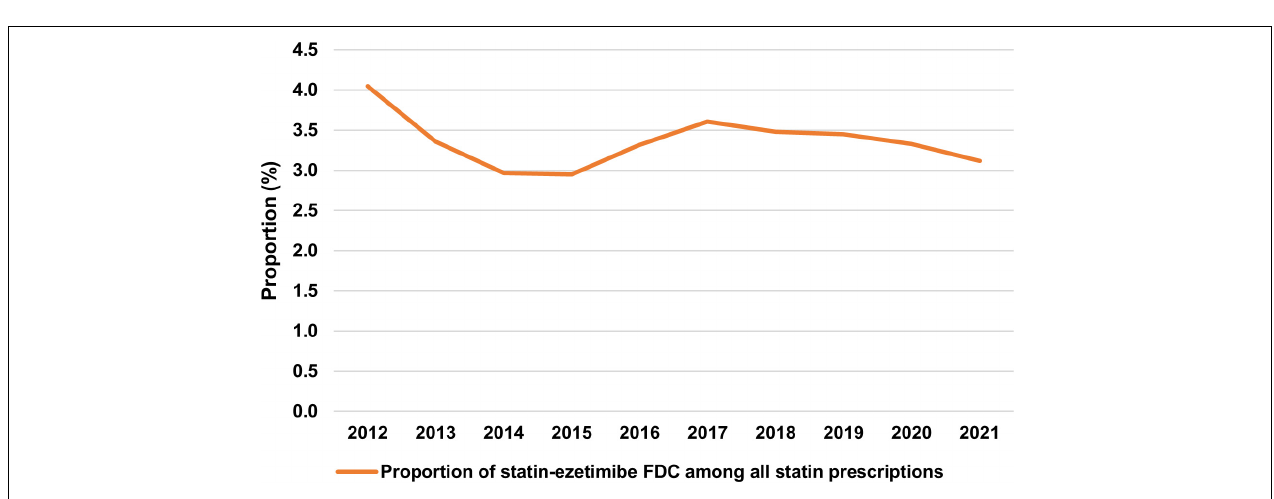
FIGURE 3 | Proportion of statin-ezetimibe FDC among all statin prescriptions. FDC, fixed-dose combinations.